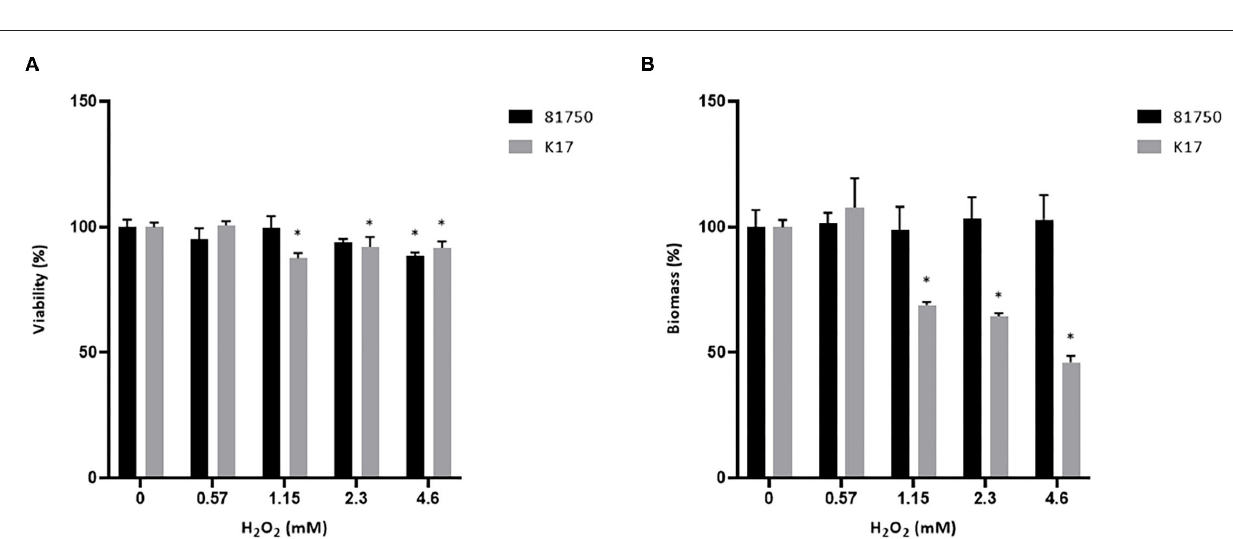
FIGURE 4 | Dose-dependent effect of H 2 O 2 on the viability (A) and biomass (B) of A. pleuropneumoniae 81750 and K17 biofilm-like structures following an exposure time of 4h. Viability was assessed using the FilmTracer LIVE/DEAD Biofilm Viability kit. Biofilm-like structure biomass was determined by crystal violet staining. Assays were performed in triplicate in three independent experiments, and the means ± SD were calculated. *Significantly different at p < 0.01 compared to the control (no H 2 O 2